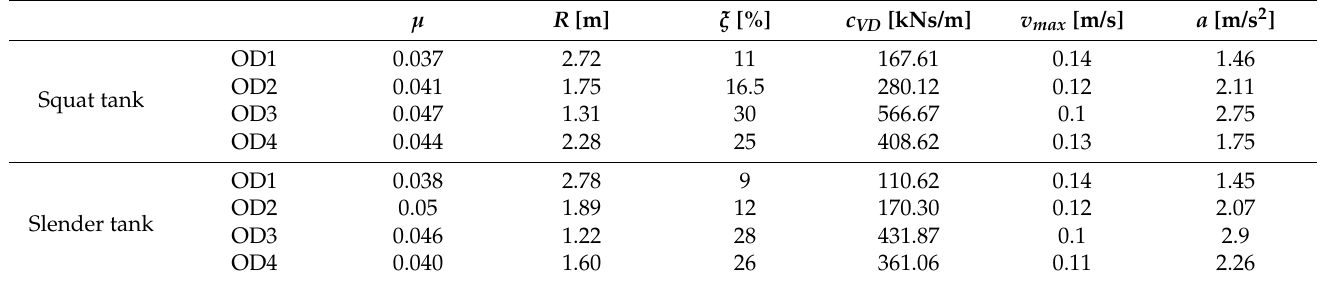
Table 3. Optimization results for the selected solutions of the MOGA1